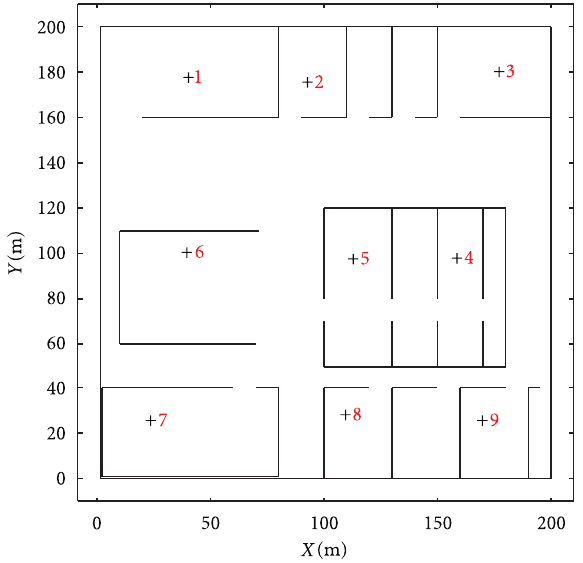
Figure 6: Layout of the simulated